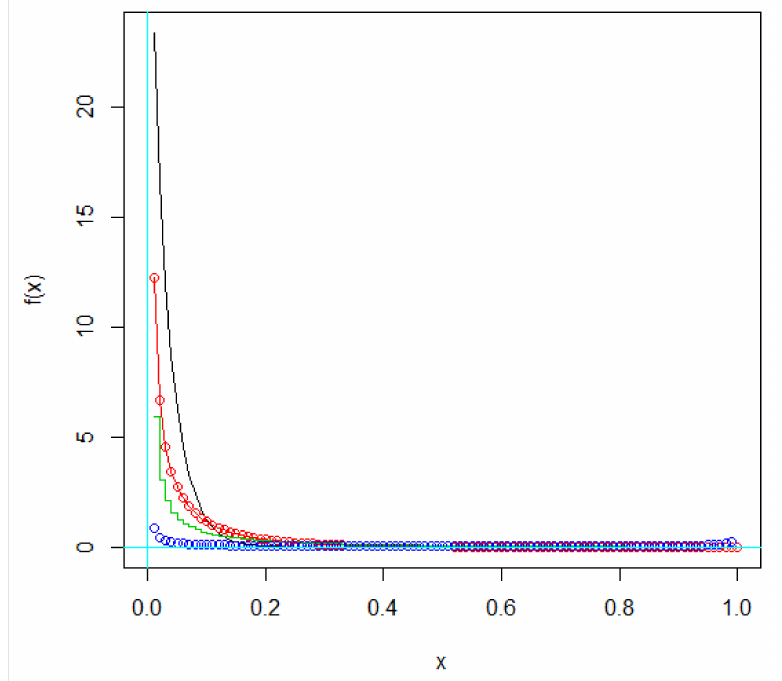
Figure 3. PDF of distribution of beta ( α , β ) in the presence of different values of CV (blue: α = 0.009, β = 0.285, CV = 5; green: α = 0.08, β = 2.51; red: α = 0.21, β = 6.87, CV = 2; black: α = 0.94, β = 30.39, CV =